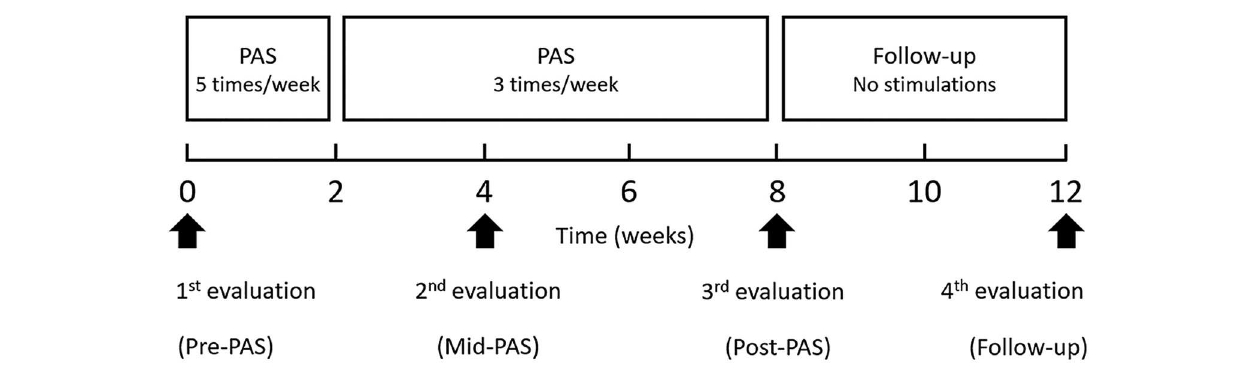
FIGURE 1 | Time course of